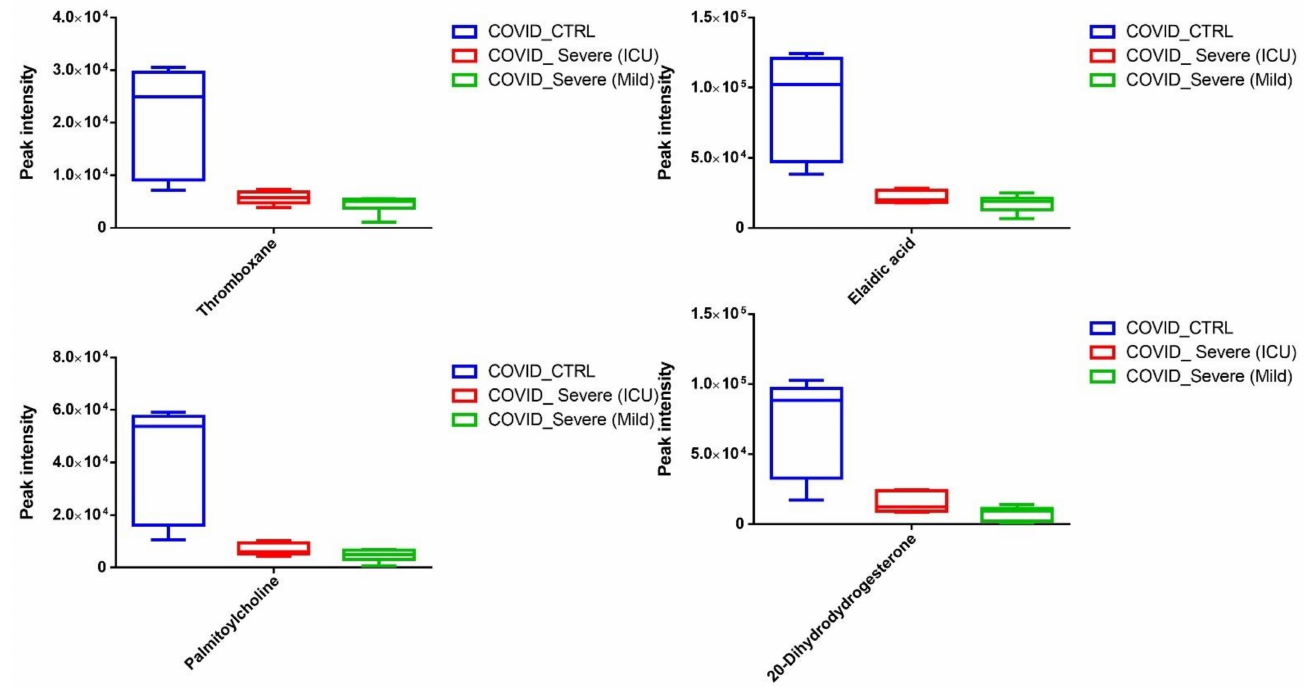
Figure 7. Quantitative level of statistically significant metabolites ( p < 0.01) found to be downregulated in COVID-19 EVs when compared to healthy control samples. Data are presented as box plot, median, and interquartile range (n =